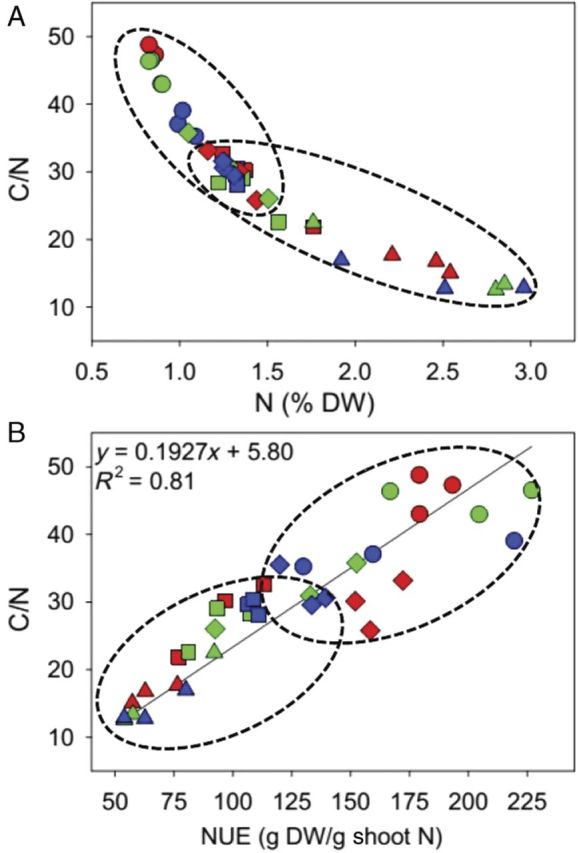
Relationship between C/N ratios and (A) nitrogen (% dry weight) and (B) NUE (g dry weight g−1 shoot N) of the salt-excreting (A. lagopoides = squares; S. tremulus = triangles) and non-excreting (P. paspalodes = circles; P. geminatum = diamonds) grasses grown under increasing NaCl treatments (0 mM = red; 200 mM = green; 400 mM = blue).